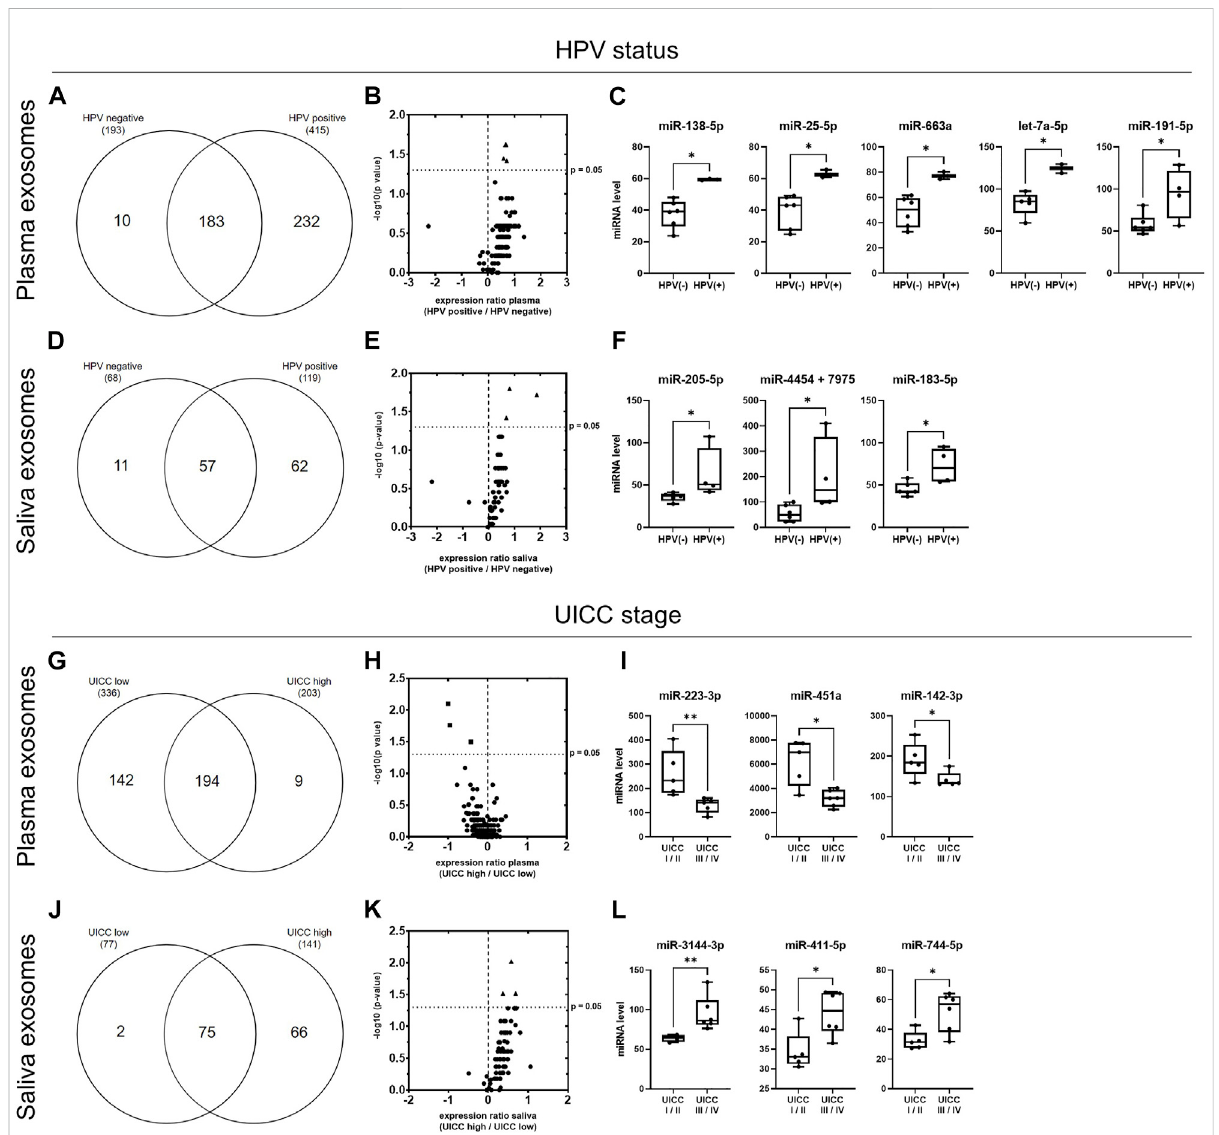
FIGURE 7 miRNA pro fi les of plasma- and saliva-derived exosomes dependent on HPV status and UICC stage. (A,D) Venn diagram of miRNAs detected in plasma- (A) andsaliva- (D) derivedexosomesofHPV − ( n =6)andHPV + ( n =4)HNSCCpatients. (B,E) Volcanoplotsshowingthelog2expressionratio of those miRNAs overlapping between patients with HPV − and HPV + disease. Each dot represents one miRNA. miRNAs at x > 0 are upregulated in exosomes from HPV + patients, while miRNAs at x < 0 are downregulated in exosomes from HPV + patients compared to patients with HPV − disease. miRNAs shown as triangle are signi fi cantly upregulated ( p ≤ 0.05, cut-off marked as y-axis intersection) in exosomes from HPV + patients. These are shown in detail in (C,F) . Individual miRNA counts from n = 10 HNSCC patients are plotted as box-and-whisker blots representing the median value, the 25th and 75th quartiles and the range. * corresponds to p ≤ 0.05, as determined by Mann-Whitney test. (G,J) Venn diagram of miRNAs detectedinplasma- (G) andsaliva- (J) derivedexosomesofHNSCCpatientwith low (n=5) andhigh (n=6) UICC stage. (H,K) Volcanoplots showing the log2 expression ratio of those miRNAs overlapping between patients with low and high UICC stage. Each dot represents one miRNA. miRNAs at x > 0 are upregulated in exosomes from UICC high stage patients, while miRNAs at x < 0 are downregulated in exosomes from UICC high compared to low stage patients. miRNAs shown as square are signi fi cantly downregulated and miRNAs shown as triangle are signi fi cantly upregulated ( p ≤ 0.05, cut-off markedas y-axis intersection) inexosomes from UICC high stage patients. These are shown in detail in (I,L) .Individual miRNA counts from n = 11 HNSCC patients are plotted as box-and-whisker blots representing the median value, the 25th and 75th quartiles and the range. * corresponds to p ≤ 0.05, as determined by Mann-Whitney